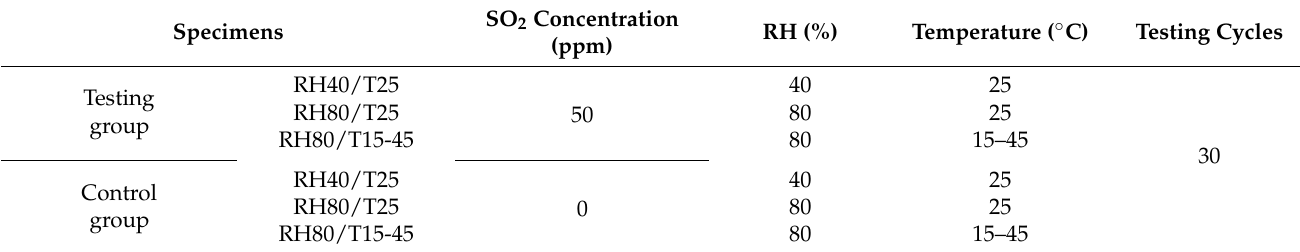
Table 4. Environmental parameters of artificially accelerated weathering